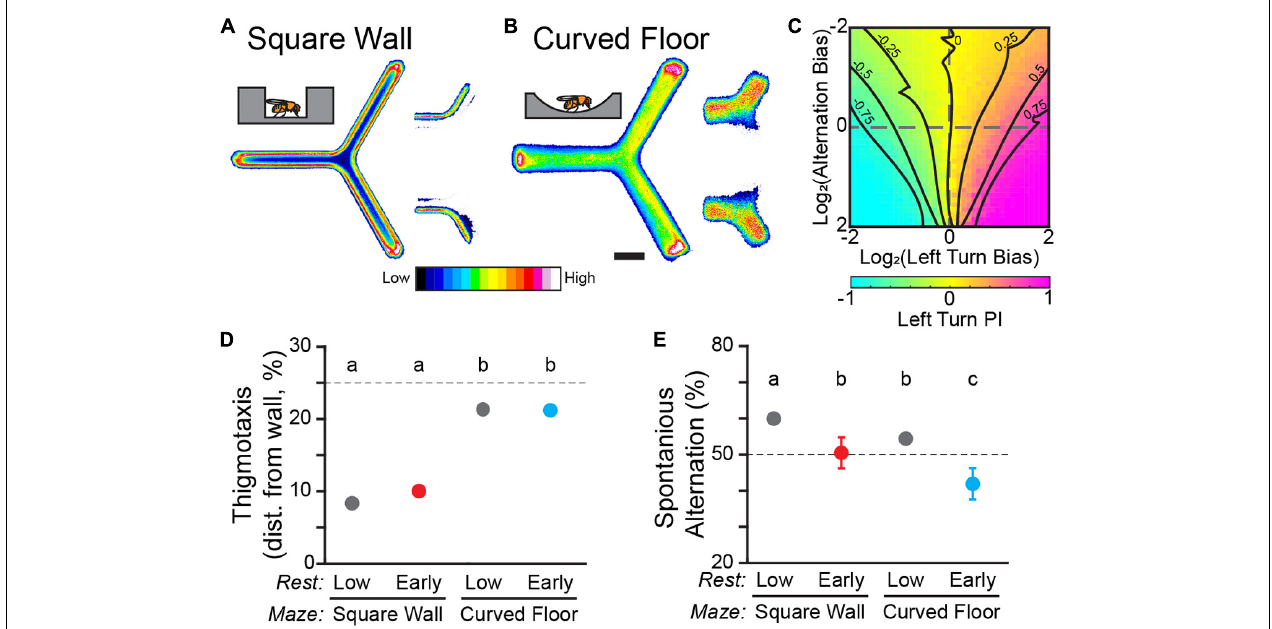
FIGURE 2 | Y-track geometry significantly affects thigmotaxis and spontaneous alternation. (A,B) Position heatmaps of flies in the square wall (A) and curved floor (B) Y-Mazes. Insets ( right ) show the heatmaps of trajectories through the center of the maze for flies walking from the left zone to the upper zone vs. the lower zone. Scale bar: 5 mm. Color shows relative occupancy of each pixel from low to high. (C) Heatmap of left turn Preference Index (PI) from a population of in silico flies. Each heatmap position is the mean of 1,000 simulated trials of a fly with a range of left-turn bias and alternation bias. Dashed lines indicate zero bias on an axis. Solid lines are smoothed contours of constant PI. (D,E) Mean thigmotaxis (D) and spontaneous alternation (E) for WT flies in square wall and curved wall experiments. (D) Thigmotaxis is defined for each fly as the median distance from the wall of walking locations. The dashed line indicates the median distance from the wall if walking locations were distributed uniformly across the hallway. (E) Spontaneous alternation is measured in the final training block. The dashed line indicates the random rate of alternation. Error bars are standard error of the mean. Groups with the same letter are not significantly different from one